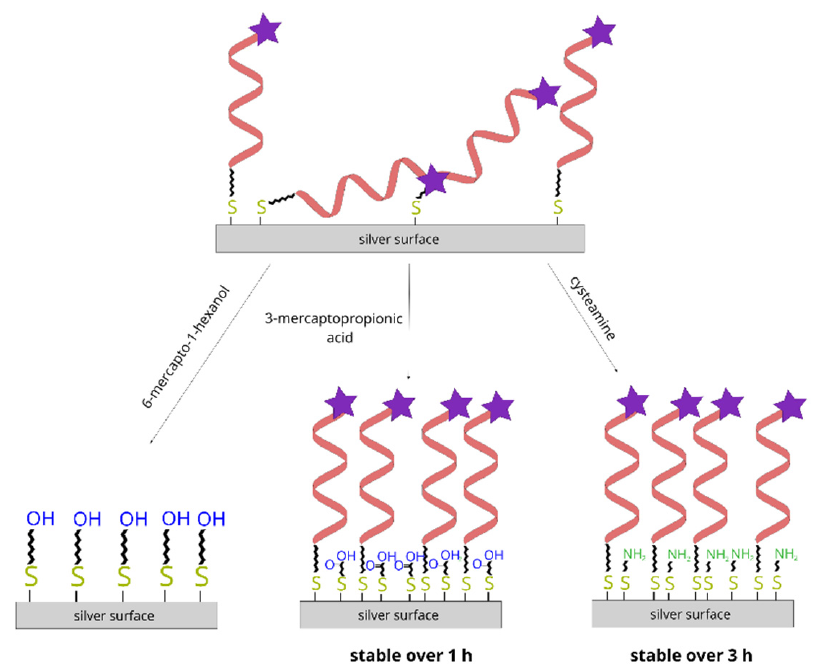
Figure 12. Diagram showing the different impact of soaking the DNA layer on silver in solutions of 6-mercapto-1-hexanol, 3-mercaptopropionic acid and cysteamine. Supplementary Materials: The following are available online, Figure S1: SERS spectra of layers formed on a nanostructured silver electrode from DNA labelled with Cy3 and MCH. Figure S2: Transmission Electron Microscopy images of used gold nanoparticles.